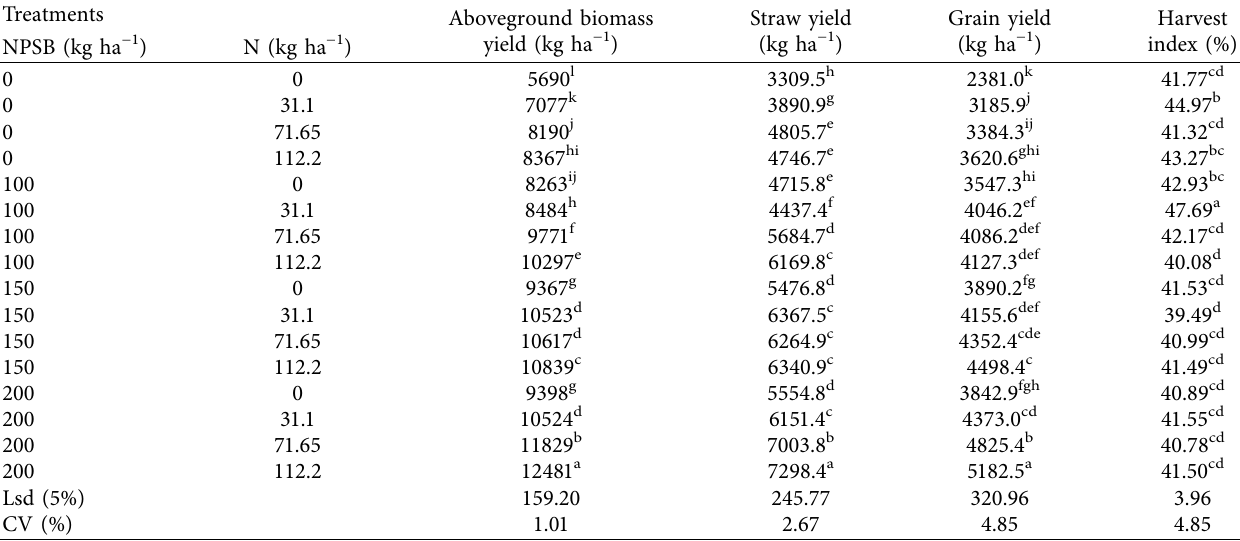
Table 7: Interaction effects of NPSB and nitrogen fertilizer rates on above-ground biomass yield, grain yield, straw yield, and harvest index. Treatments